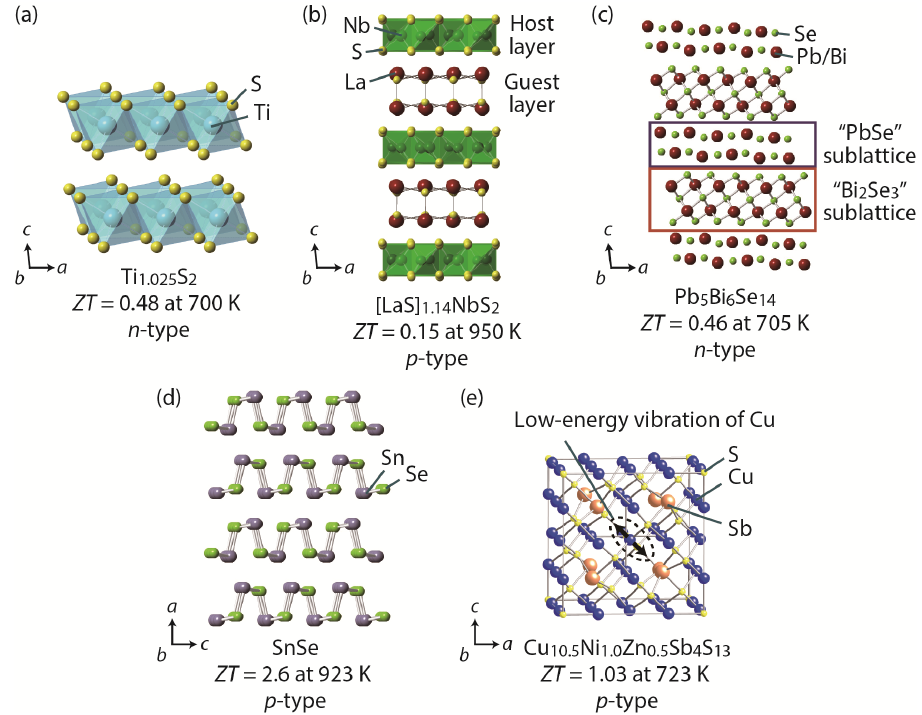
Figure 1. Crystal structures of the thermoelectric sulfides and chalcogenides addressed